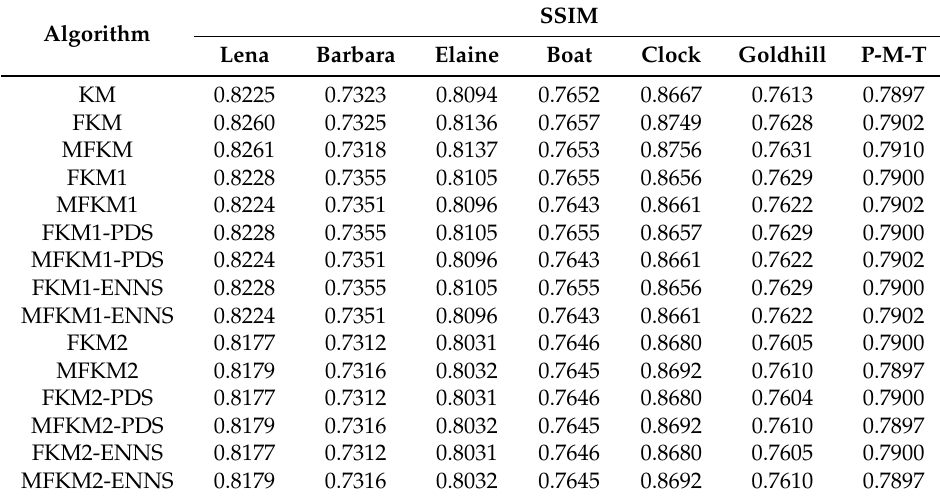
Table 11. SSIM for images Lena, Barbara Elaine, Boat, Clock, Goldhill and P-M-T, using N =